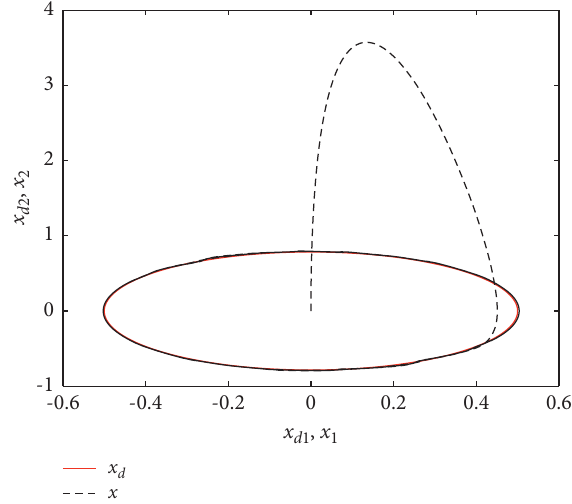
Figure 2: Convergence behavior ( x ⟶ x